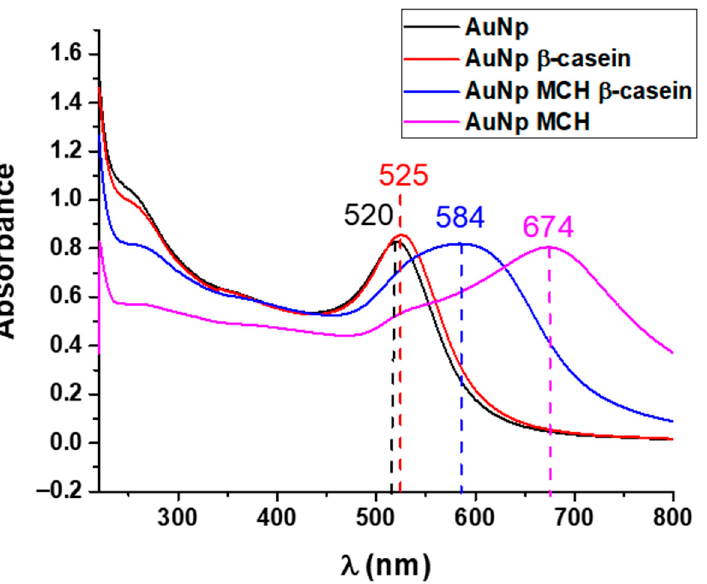
Figure 6. UV-vis absorption spectra of gold nanoparticles (AuNPs): bare (black), modified by β - casein (red), and subsequently modified by 6-mercapto-1-hexanol (MCH) (blue) as well as AuNPs modified by MCH (magenta).